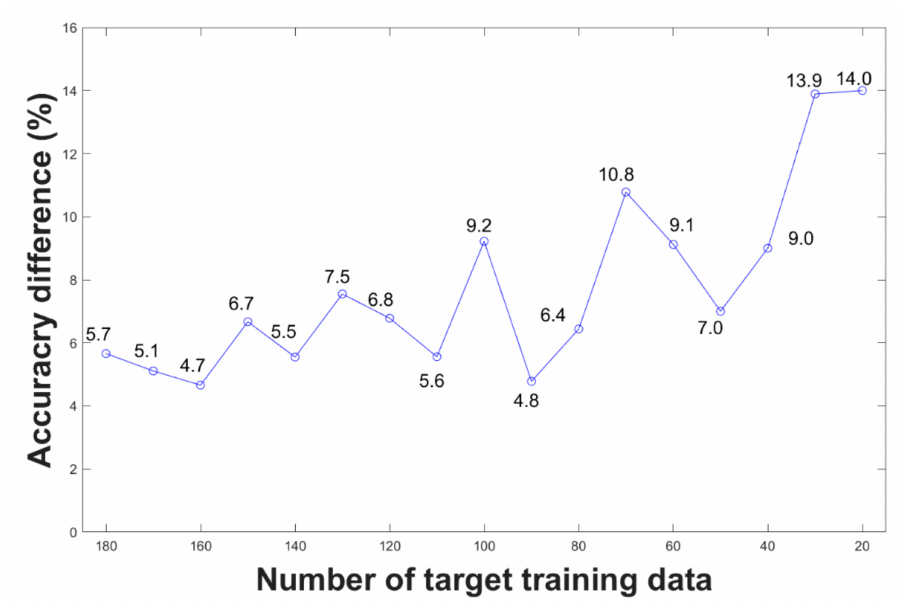
Figure 6. Accuracy difference between the proposed and non-transfer learning